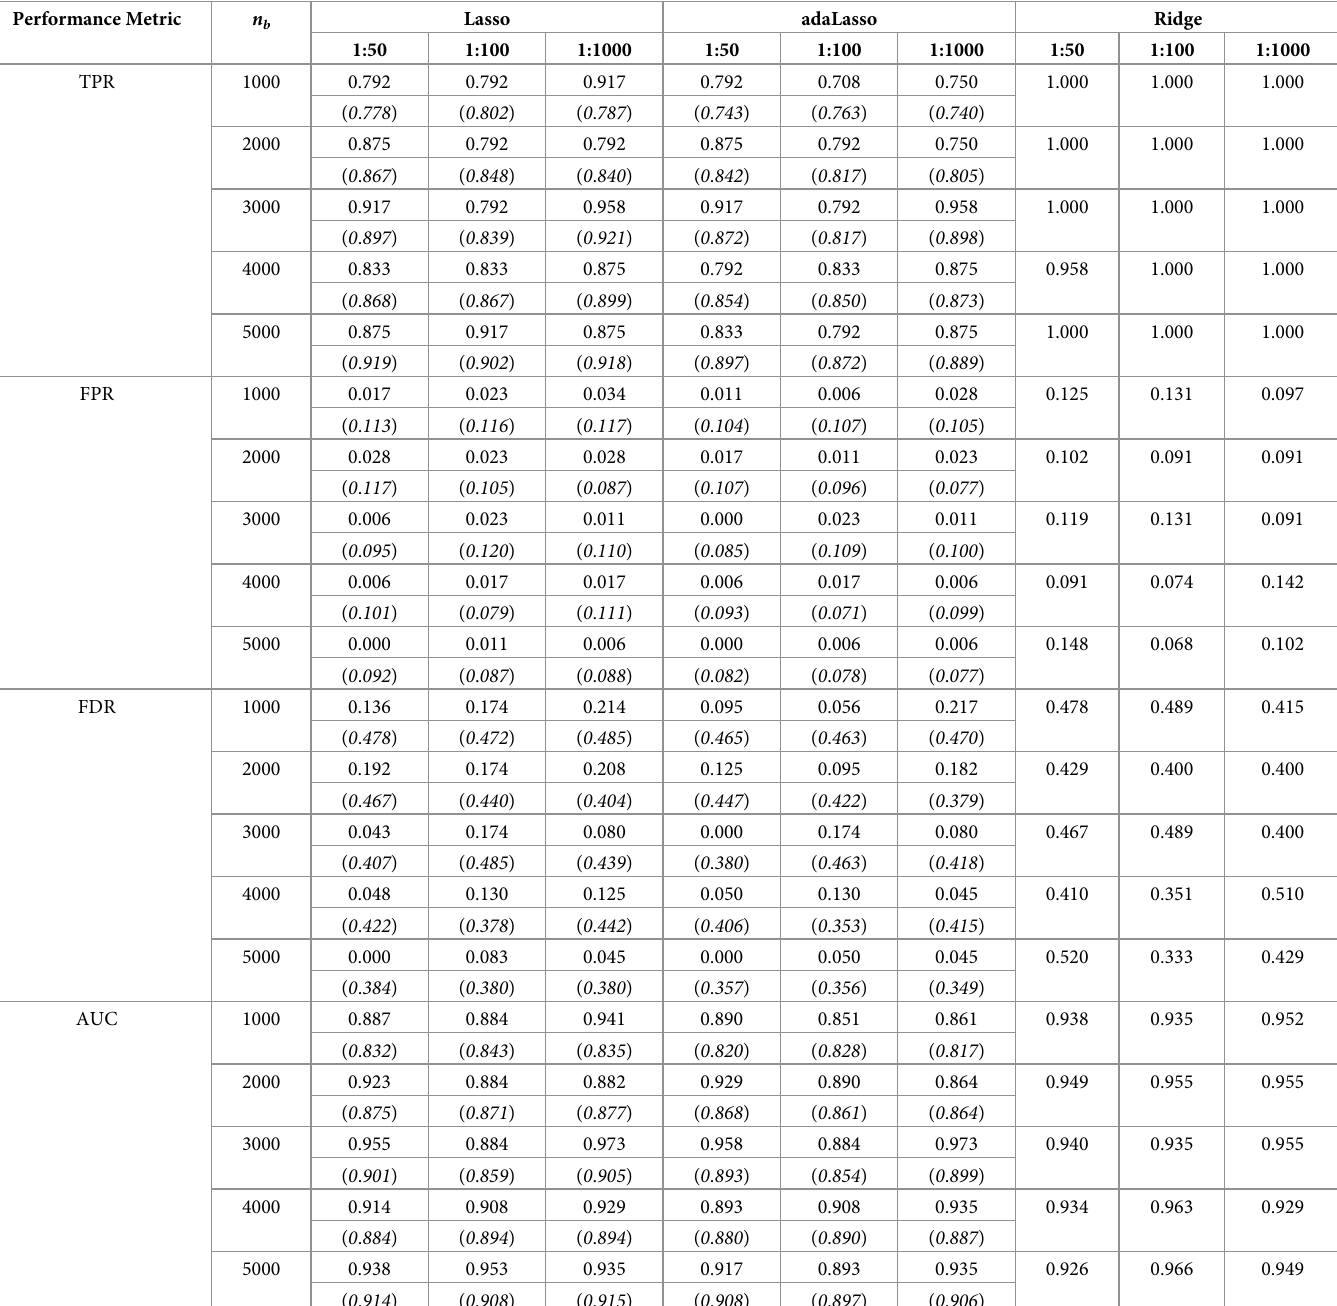
Table 6. Simulation under COR-24. Performance metric scores for variable selection based on the SVRS algorithm and average scores (reported in parenthesis) across 500 individual fits of each regularization model with imbalance ratios 1:50, 1:100 and 1:1000. Performance scores for individual ridge regression fits are not applicable as it does not perform automatic variable